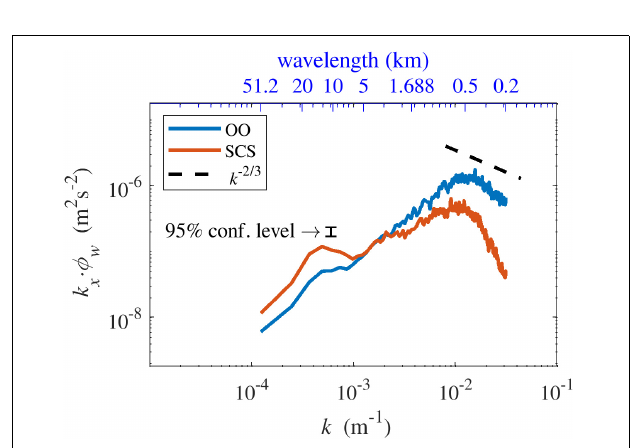
FIGURE 6 | Horizontal distribution of vertical velocity at z = − 60 m after 20 days of cooling in the (A,B) OO and (C,D) SCS experiments. The blue and black solid lines in (C) are the lower and upper boundaries of the continental slope, respectively.